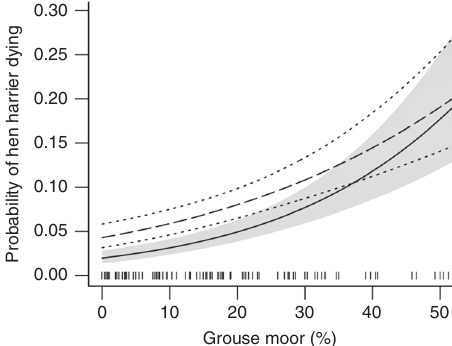
Fig. 2 Probability of hen harrier dying in relation to grouse moors. The percentage of grouse moor habitat is calculated from a 20 × 20 km 2 grid in the UK mainland and Isle of Man. The probability of a hen harrier dying is derived from a generalized linear model testing the proportion of fi xes from hen harriers ’ terminal weeks. Solid line represents all harriers with con fi dence intervals (CIs) shaded grey; dashed line represent data from harriers that were known to have been illegally killed (I) and those with tags that stopped suddenly with no prior indication of a malfunction (SNM) only, with CIs shown by dotted lines. Source data are provided as a